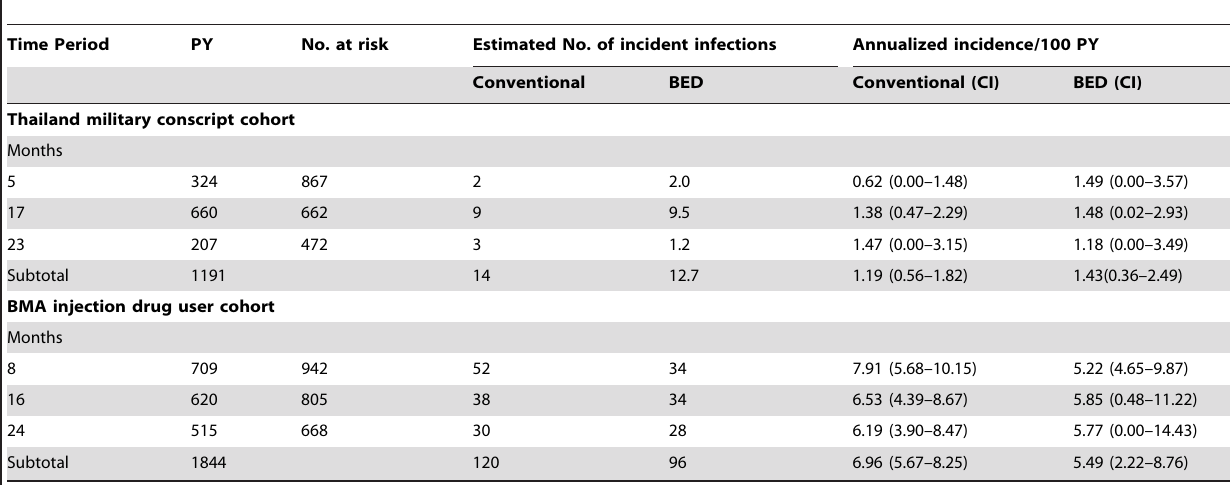
Table 1. Comparison of conventionally and BED-estimated incidence in two